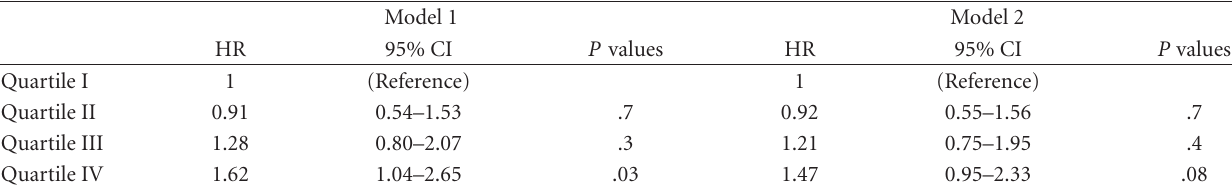
Table 3: Hazard ratios (HR, 95% Confidence Interval (CI)) of cerebrovascular events by quartile of pulse